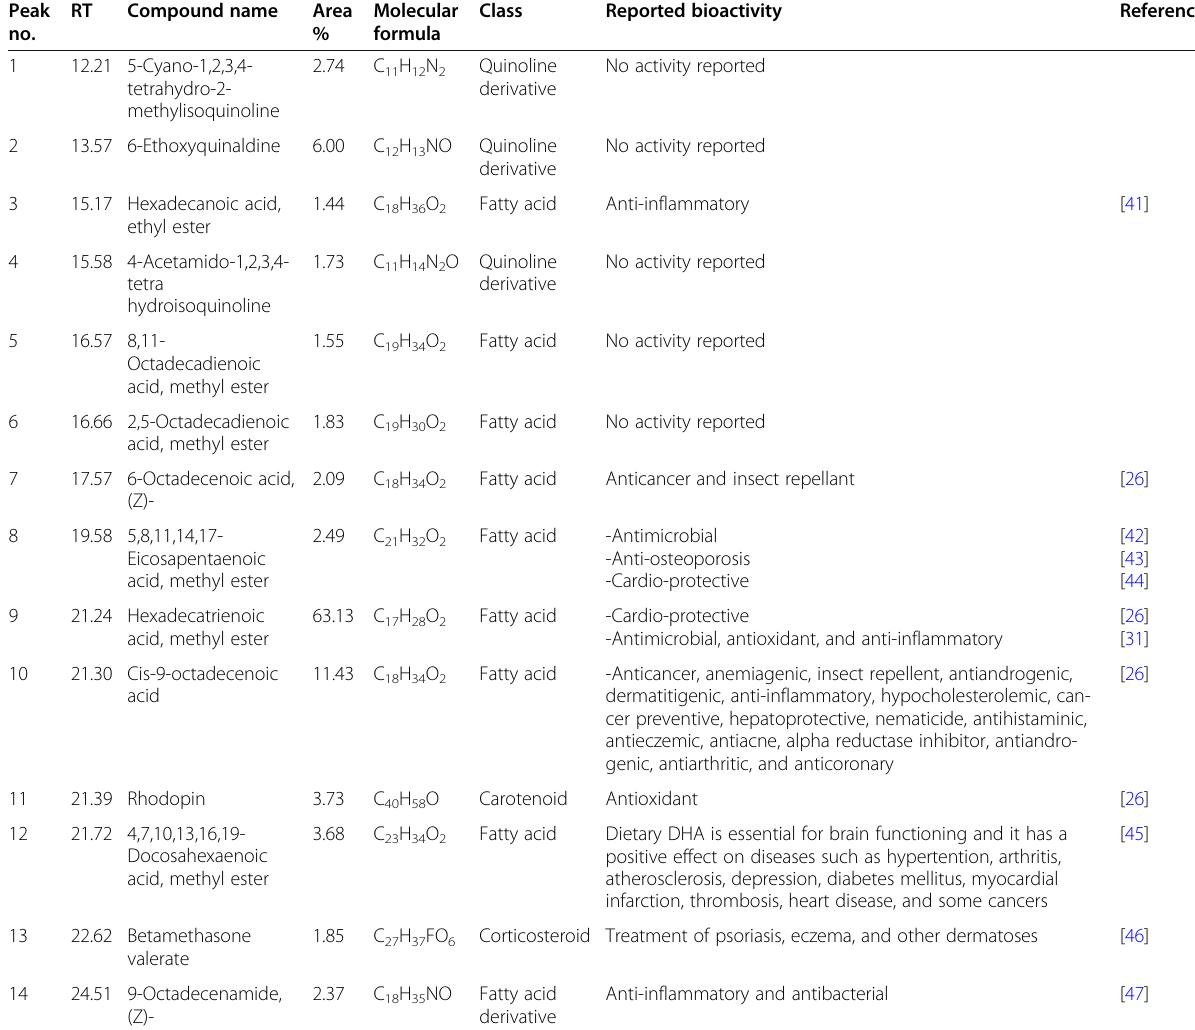
Table 5 Phytochemical components of Peganum harmala ethanolic extract as identified by GC-MS analysis Peak